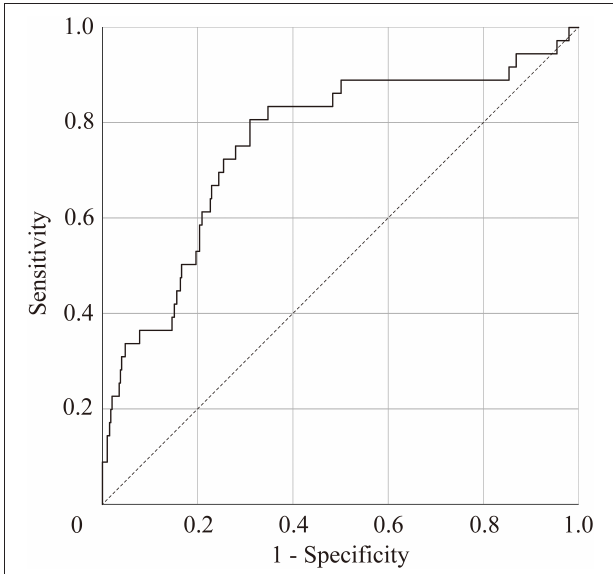
FIGURE 3 | Receiver-operator curve (ROC) to predict patients with major depressive disorder. Area under the ROC = 0.76 (standard error = 0.05, p = 1.2 × 10 − 7 , 95% confidence interval, 0.67–0.85).